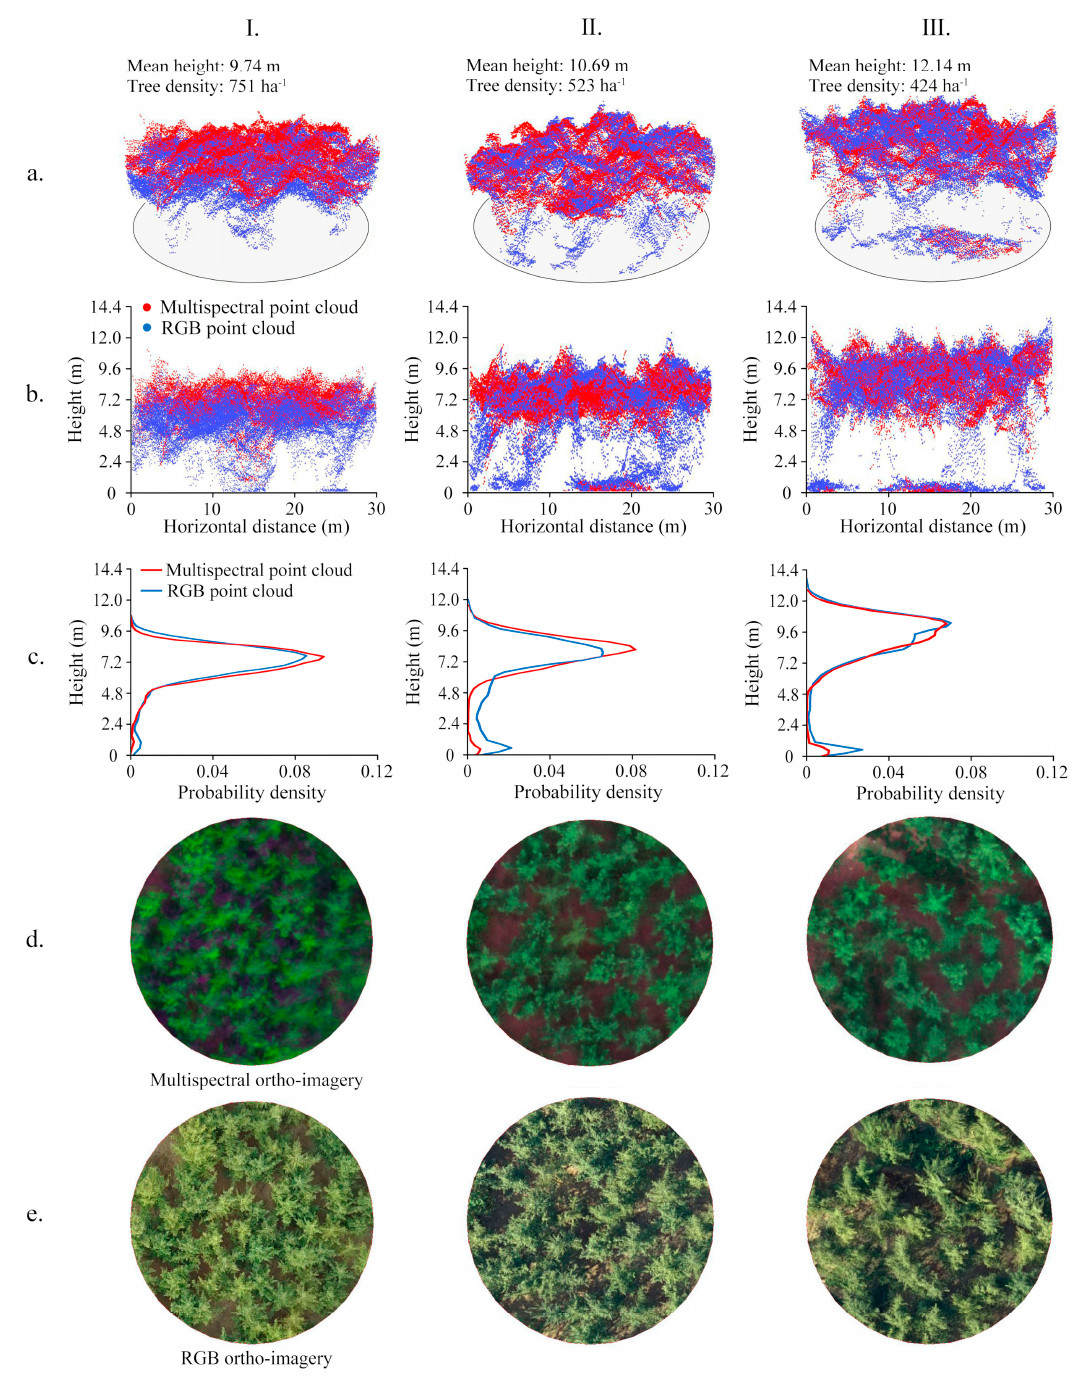
Figure 4. The point clouds and ortho-imageries derived from UAS multispectral and RGB imageries using DAP approach and the height distribution of point clouds in three typical plots. ( a ) Three dimensional display of point clouds; ( b ) the profile of point clouds; ( c ) the height distribution of point clouds; ( d ) the ortho-imagery of multispectral data; ( e ) the ortho-imagery of RGB data; ( I ) the plot with low tree height and high stem density; ( II ) the plot with medium tree height and medium stem density; and ( III ) the plot with high tree height and low stem density.